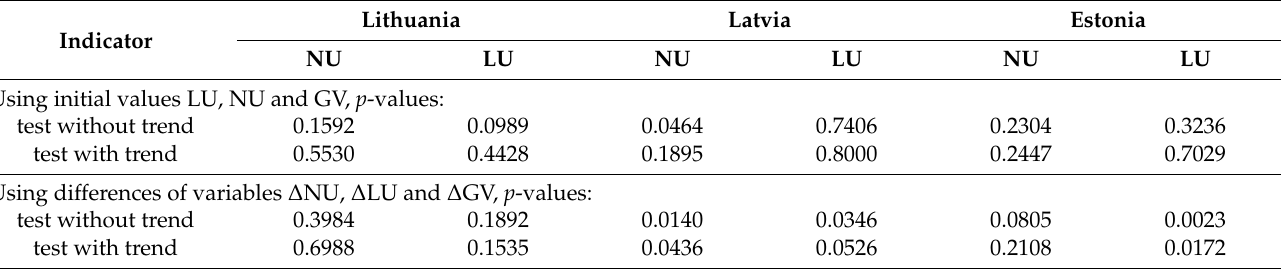
Table 3. Engle–Granger co-integration test